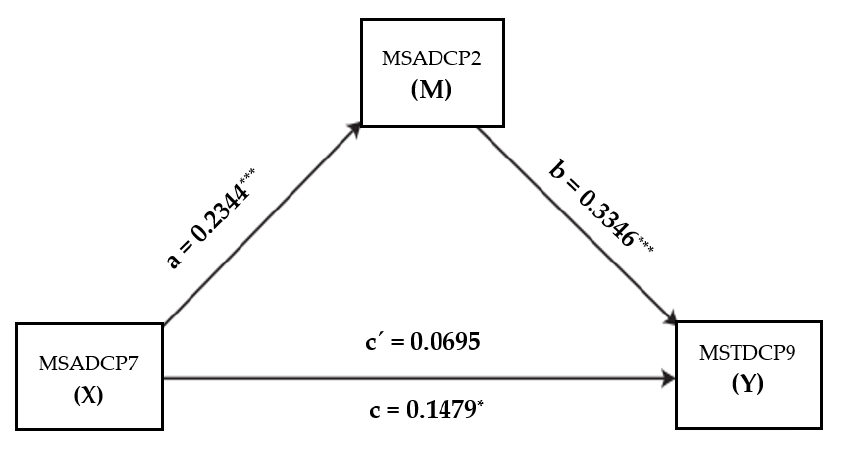
Figure 4. Mediation of satisfaction with the Corona bonus on the effect of the perceived support from superiors over the perceived occupational workload. * p -value <0.05; *** p -value < 0.001.